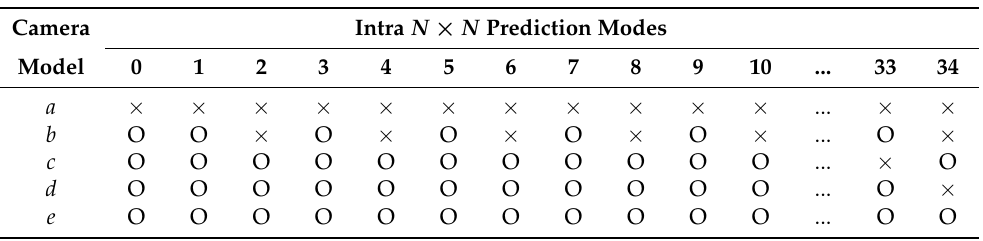
Table 11. Example of intra N × N prediction modes of 8 × 8 CU in HEVC encoder’s descriptors. Here, O and × represent ‘used’ and ‘not used’, respectively. Camera Intra N × N Prediction Modes Model